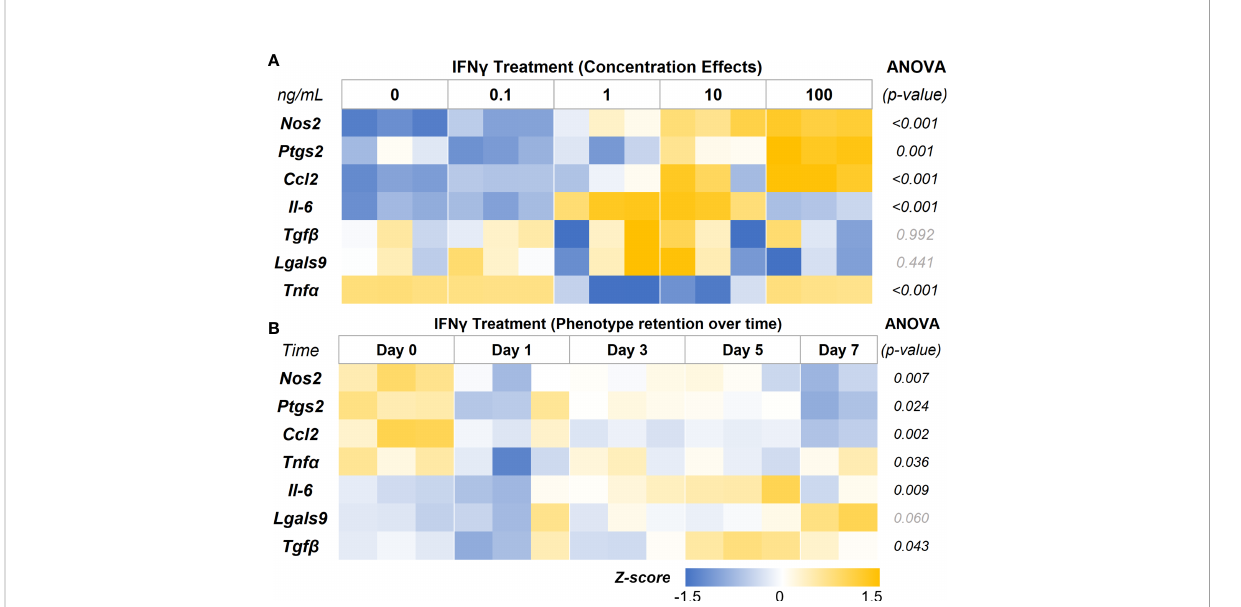
FIGURE 5 IFN g Licensing and Retention of AD-MSC Immunomodulatory Phenotype. (A) Heatmap of the AD-MSC gene expression after 24 hours of licensing using different concentrations of IFN g shows a concentration-dependent effect. (B) Heatmap of AD-MSC licensed for 24 hours using 10 ng/mL IFN g showing robust phenotype retention over